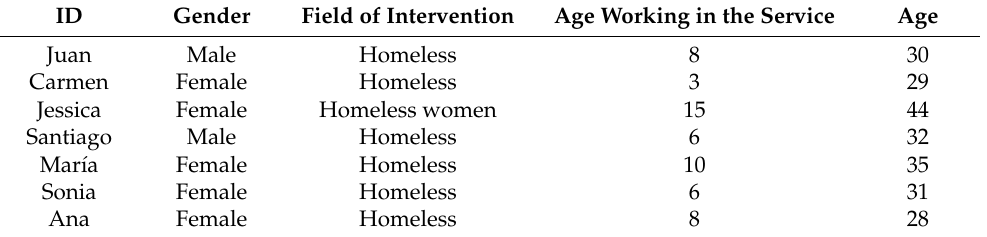
Table 1. Participants’ profiles.